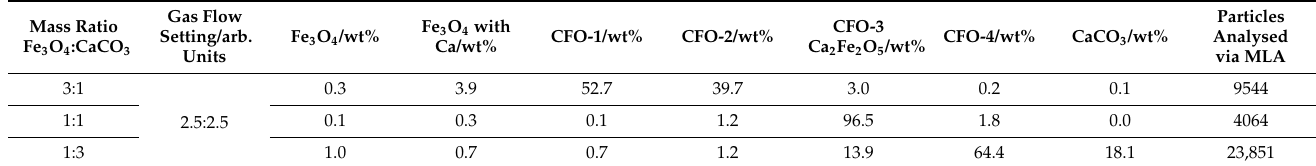
Table 3. Mineral proportion (wt%) of flame spheroidised products, as a function of precursor to porogen mass ratio.